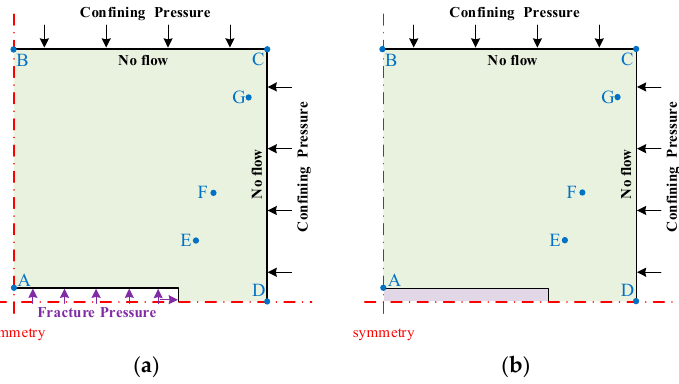
Figure 4. Boundary conditions for different treatment of the fracture. ( a ) The fracture is regarded as a void; ( b ) the fracture is regarded as a soft inclusion. Table 2. Material properties used in simulations.